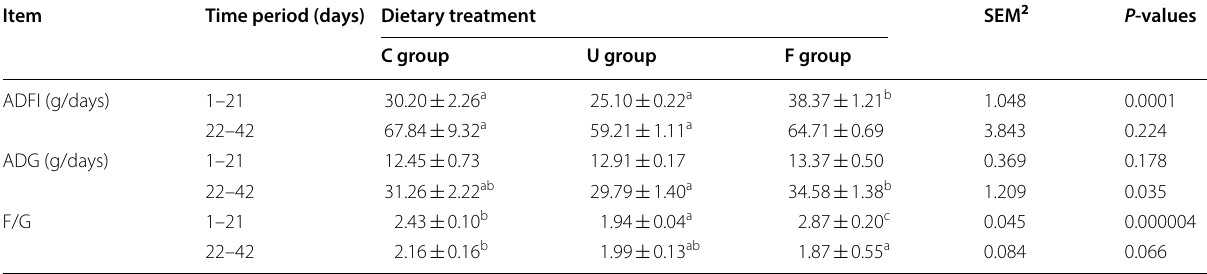
C group basal diet; U group = ADFI average daily feed intake, ADG average daily gain, F/G feed gain ratio a,b,c Means in the same row bearing different superscripts differ significantly ( P